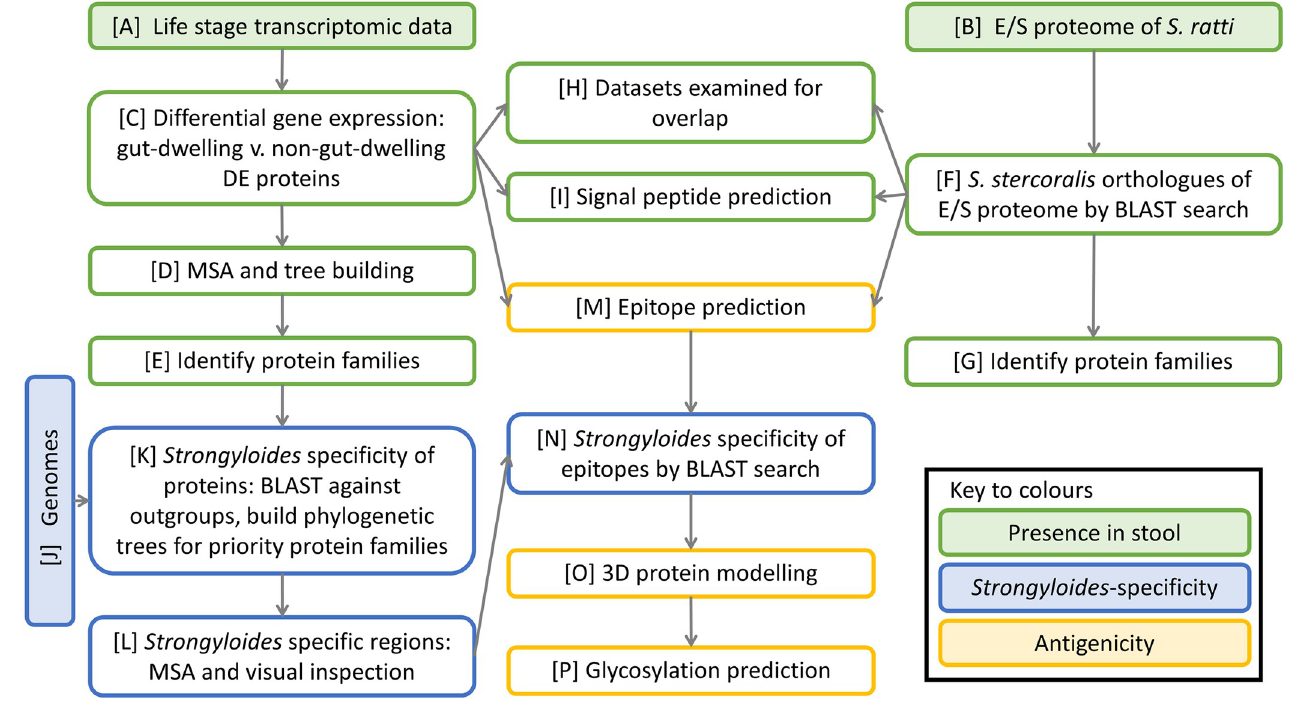
Fig 1. Schematic of the method for identifying coproantigens of Strongyloides stercoralis using ‘omic’ data and computational analyses. Filled shapes represent datasets, colours represent analyses against three characteristics of a candidate coproantigen. E/S, excreted and secreted; MSA, multiple sequence alignment; Ss, Strongyloides stercoralis ; BLAST, basic local alignment search tool; DE, differentially expressed.